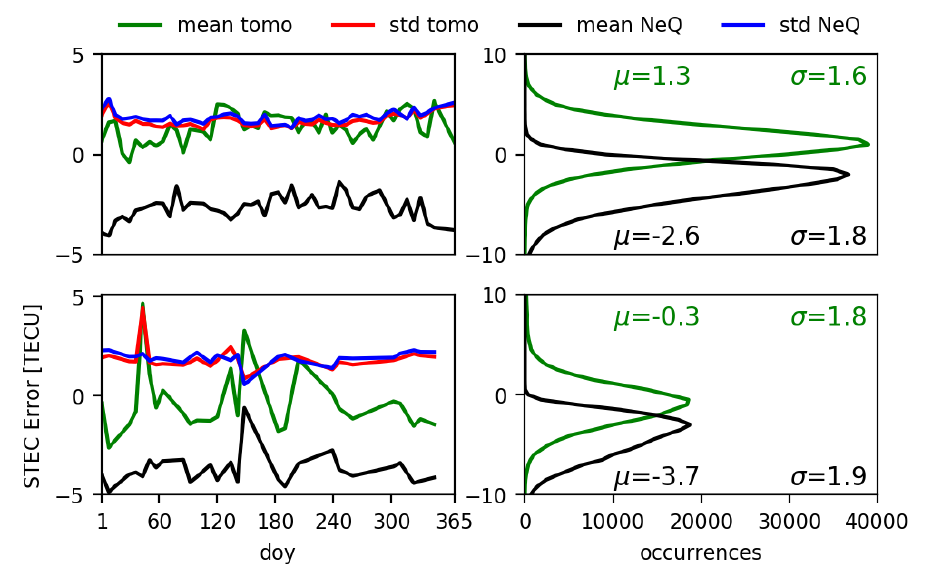
Figure 17. Electron density errors of the tomography and NeQuick with respect to the METOP-A satellite data. The left panel shows the temporal series of the standard deviations and daily averages of the errors computed for 2013 ( top ) and 2018 ( bottom ). The right panel shows the histogram of the errors together with the total error mean ( µ ) and standard deviation ( σ ) of the